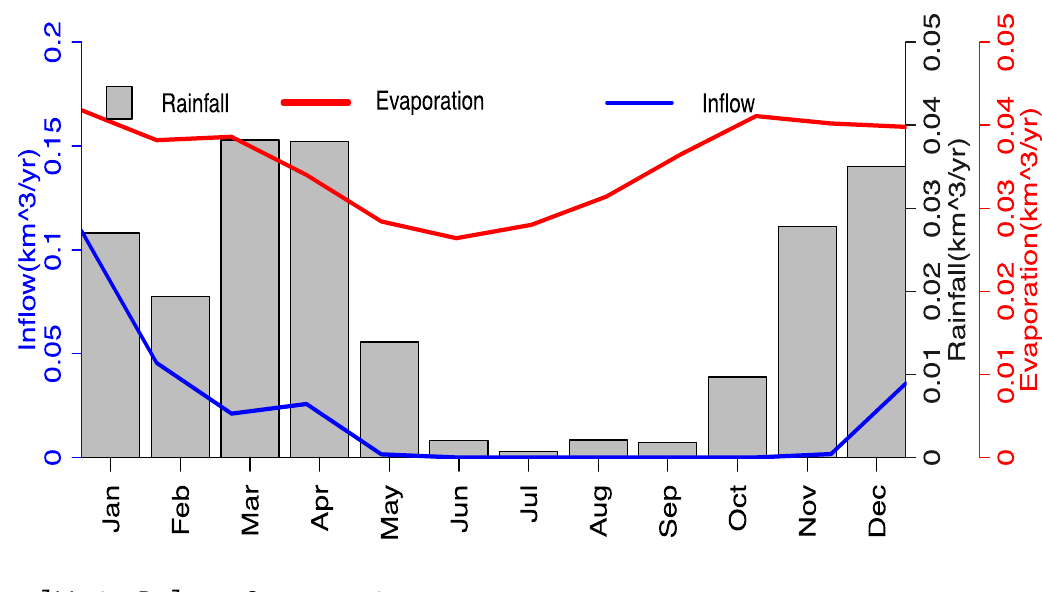
Figure 12. Mean monthly yearly water balance parameter variation for Lake Manyara